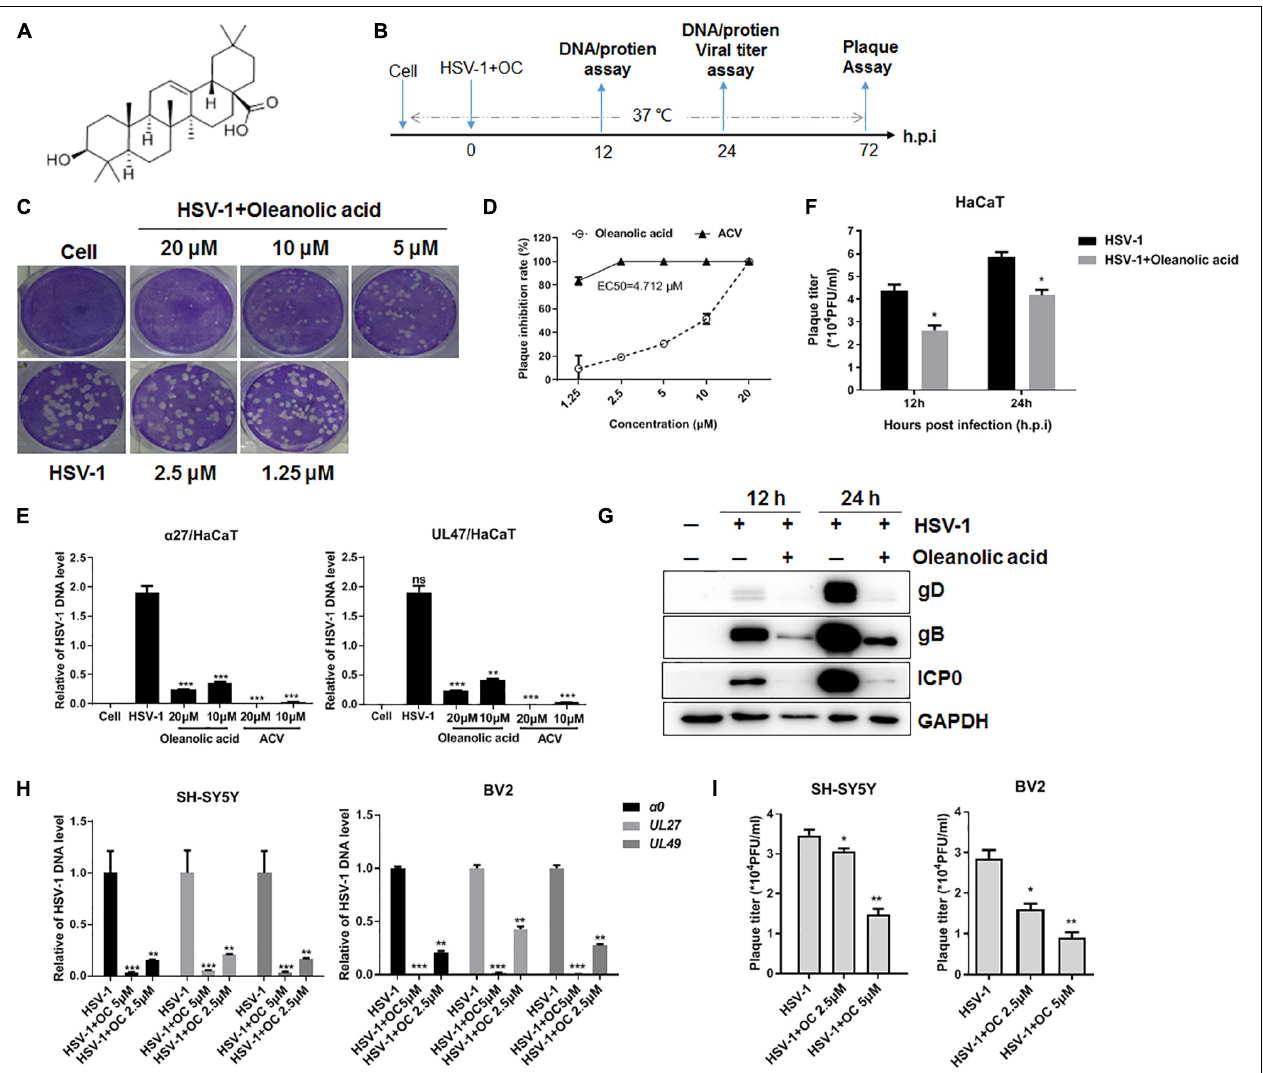
FIGURE 1 | The anti-HSV-1 activity of Oleanolic acid. (A) Chemical structure of Oleanolic acid. (B) Simple diagram of the performed experiments. (C,D) Vero cells were infected with HSV-1 (MOI = 1) in the presence of Oleanolic acid or ACV at different concentrations for 72 h. The cells were then fixed and stained with crystal violet dye. The plaque numbers were counted to calculate the inhibition rate. Data are mean ± SD ( n = 2). (E) HaCaT cells were treated with HSV-1 (MOI = 1) and Oleanolic acid for 24 h. Viral DNA was extracted and the DNA copy number of viral gene α 27 and UL47 were determined by qRT-PCR. Data are mean ± SD ( n = 3). ** p < 0.01, *** p < 0.001. (F,G) HaCaT cells were treated with HSV-1 (MOI = 1) and Oleanolic acid for 12 or 24 h, respectively. Virus titration (F) and the expression levels of viral protein ICP0, gB, and gD (G) were detected. Data are mean ± SD ( n = 3). * p < 0.5. (H,I) SH-SY5Y and BV2 cells were infected with HSV-1 (MOI = 1) in the presence or absence of Oleanolic acid (OC) at indicated concentrations for 24 h. Total viral DNA was extracted and the DNA copy numbers of viral genes α 0, UL27, and UL49 were determined by qRT-PCR (H) . The supernatant and cell pellets were collected to calculate virus titers (I) . Data are mean ± SD ( n = 3). * p < 0.5, ** p < 0.01, *** p <